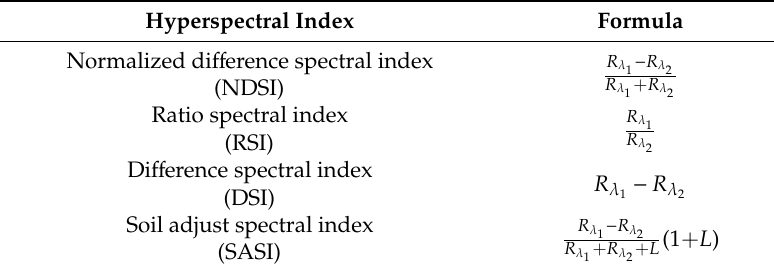
Table 1. Names and algorithms of the spectra indices used in this